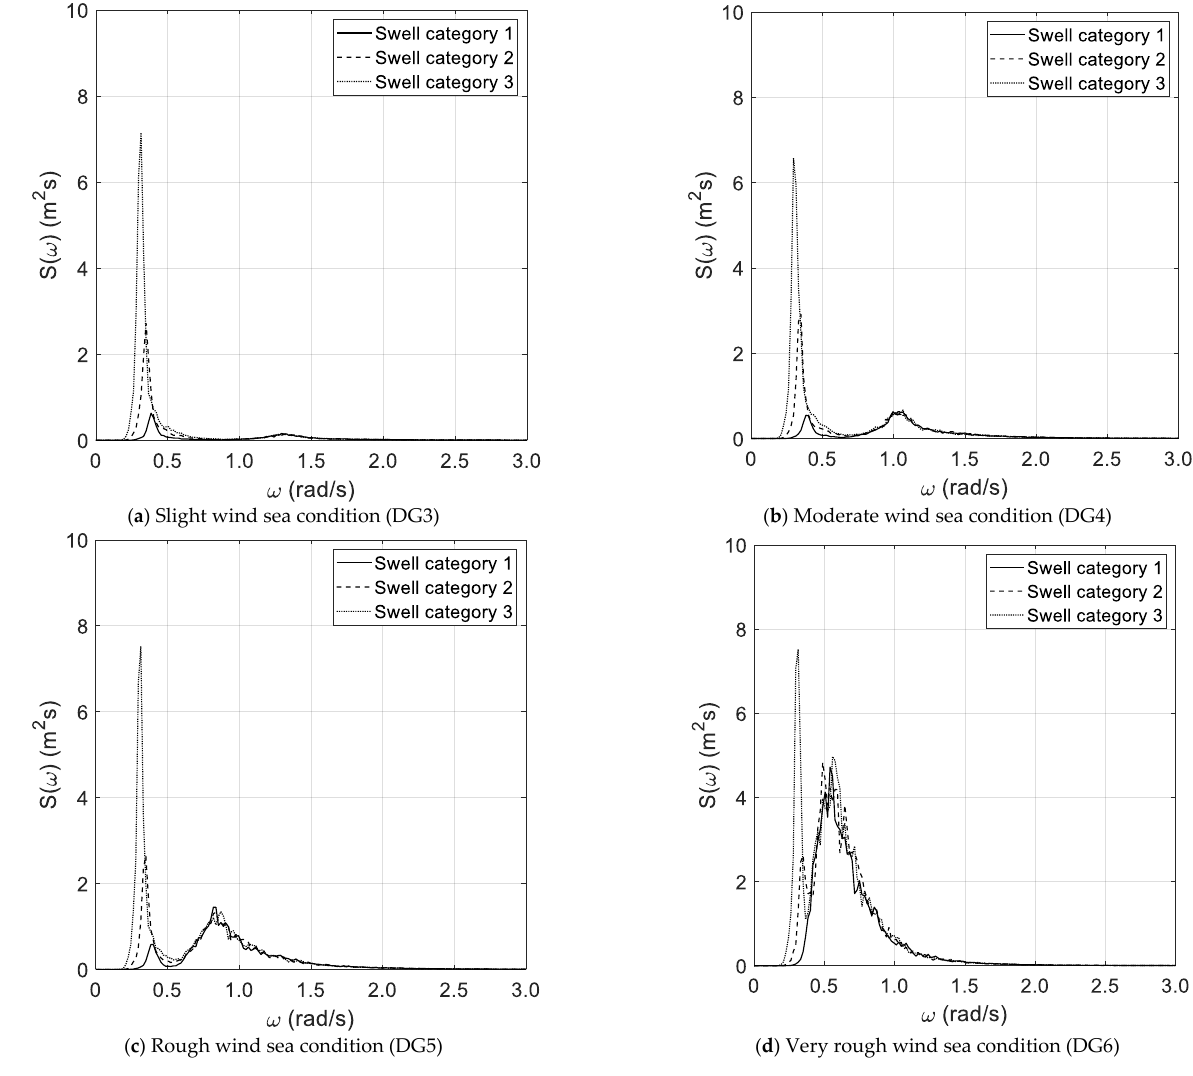
Figure 3. Spectral analysis (Welch)—long duration.